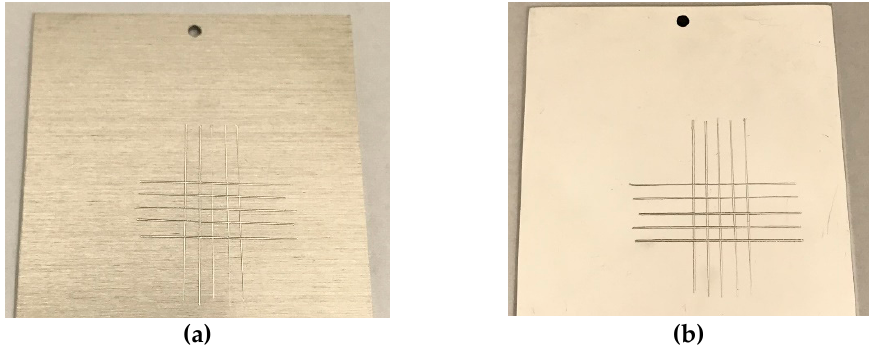
Figure 7. Photo of the nickel-plated ( a ) unpolished and ( b ) polished samples after the adhesion test. The cross-cuts are evident but no detachment of the coating was observed.